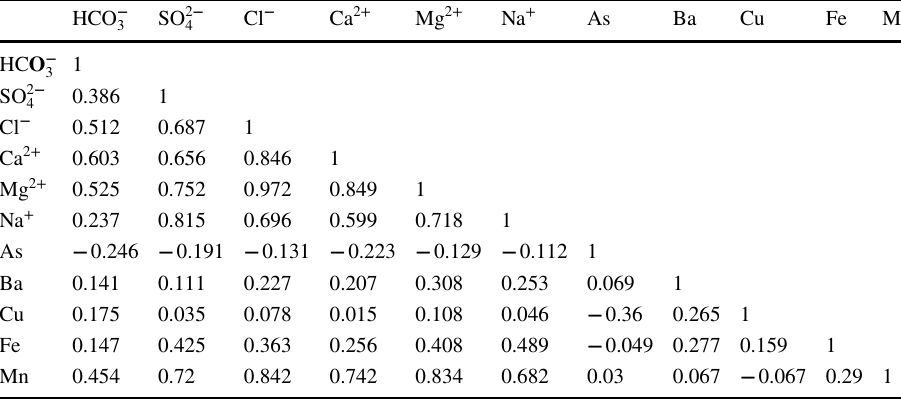
Table 2 Correlations between most elements present in groundwater of study